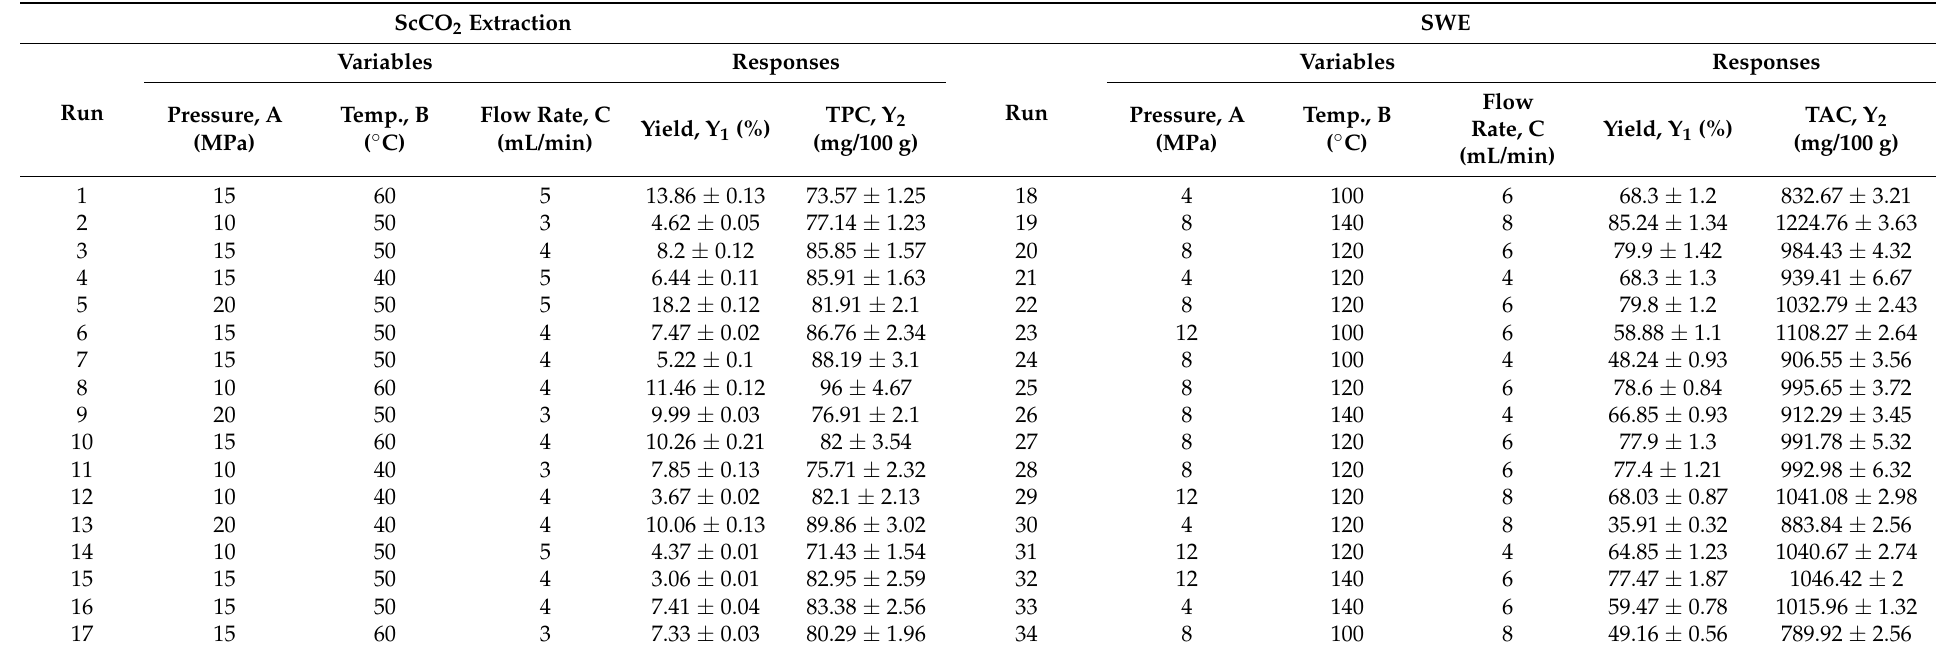
Table 1. The variables and responses of a combination of ScCO 2 extraction and